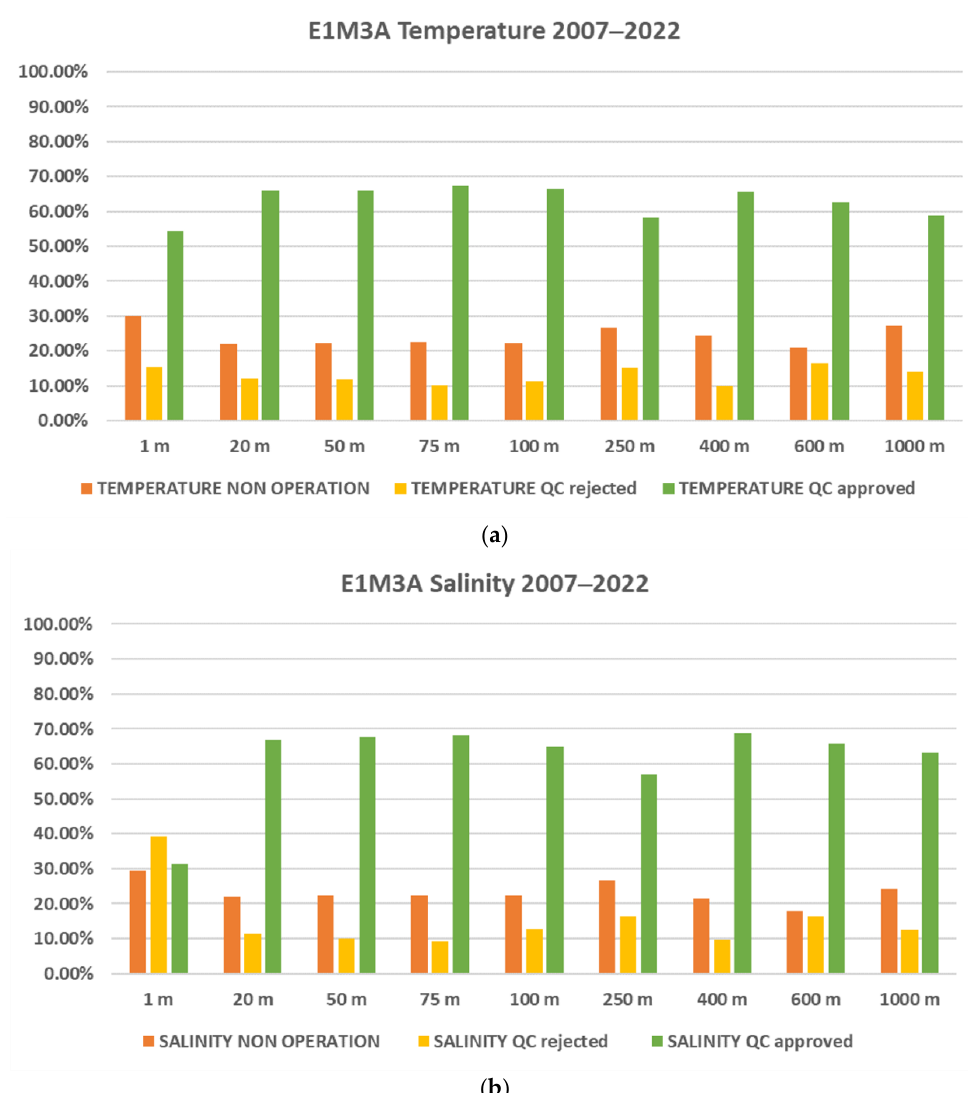
Figure 13. E1M3A percentage of the quality-approved data, the rejected data during quality control (QC), as well as the percentage of non-operation periods of the station or sensors for temperature ( a ) and salinity ( b ).